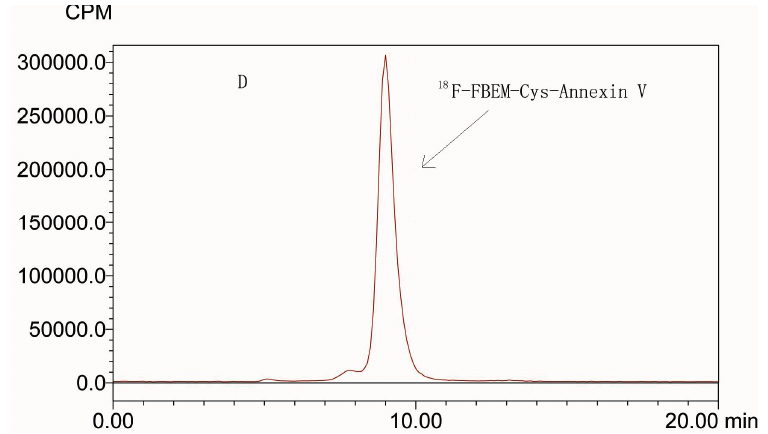
Figure 1. HPLC chromatogram (isocratic, 0.05 mol/L phosphate buffer (pH = 7.0), flow 0.8 mL/min) of: ( A ) Cys-Annexin V, t R = 8.6 min (UV); HPLC radiochromatograms of ( B ) 18 F-FBEM, t R = 15.9 min, ( C ) reaction mixture ( 18 F-FBEM-Cys-Annexin V, t R = 9.1 min, 18 F-FBEM, t 18 F-FEBM-Cys-Annexin V, t R = 15.9 min) and ( D ) R = 9.1 min.